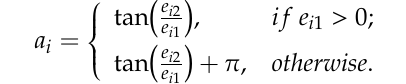
Figure 4. The correlation is implemented using the corrplot (https: // cran.r-project.org / web / packages / corrplot / vignettes / corrplot-intro.html) R library